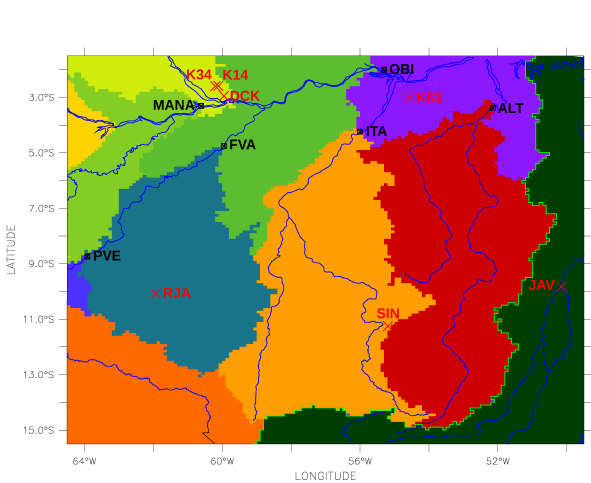
Fig. 7. Map of locations of flux towers stations (in red). See Table 5 for the coordinates of the stations. Color is used to distinguish the different sub-basins. For topographic scale, see Fig. 2.